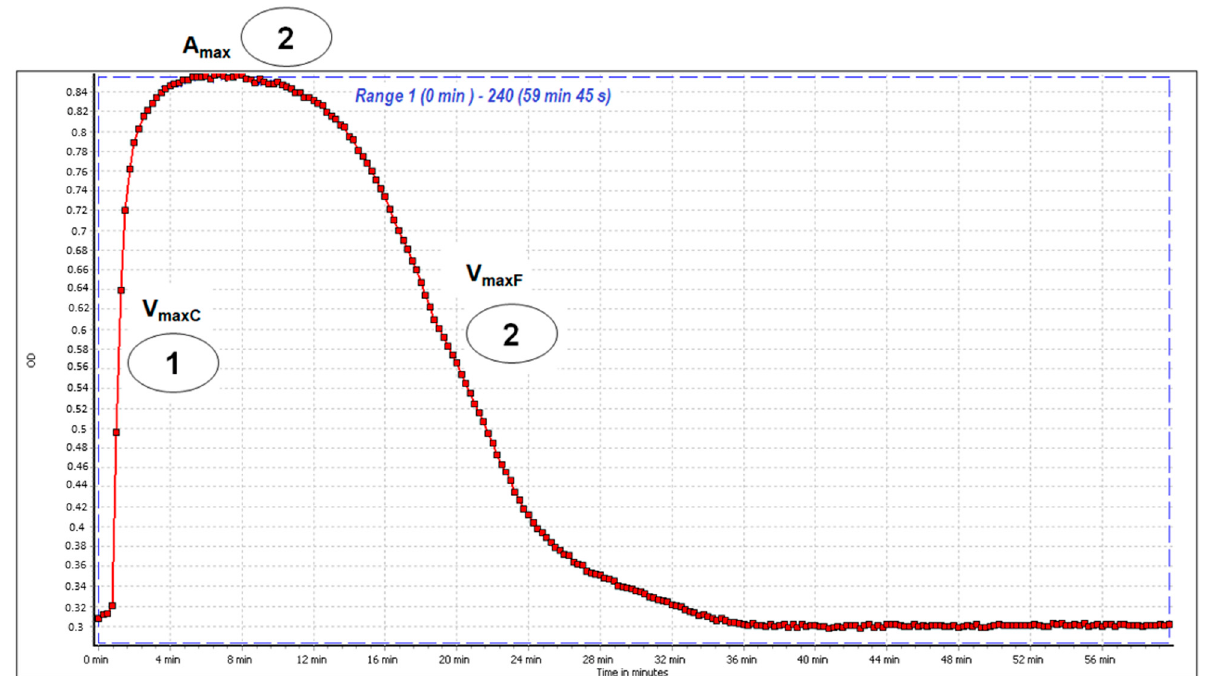
Figure 11. An exemplary curve of blood plasma coagulation and clot lysis recorded during the clot formation and fibrinolysis (CFF) assay. The first step in the CFF test involves activation of the blood plasma coagulation cascade and fibrin clot formation (1). It is characterized by the maximal velocity of the fibrin polymerization parameter (V maxC ). The maximal absorbance (A max ) peak corresponds to the fibrin stabilization phase and is an indicator of fibrin clot thickness (2). The third step of the CFF assay covers the activation of fibrinolytic mechanisms and fibrin clot degradation (3) and is described by the maximal velocity of clot lysis (V maxF ).